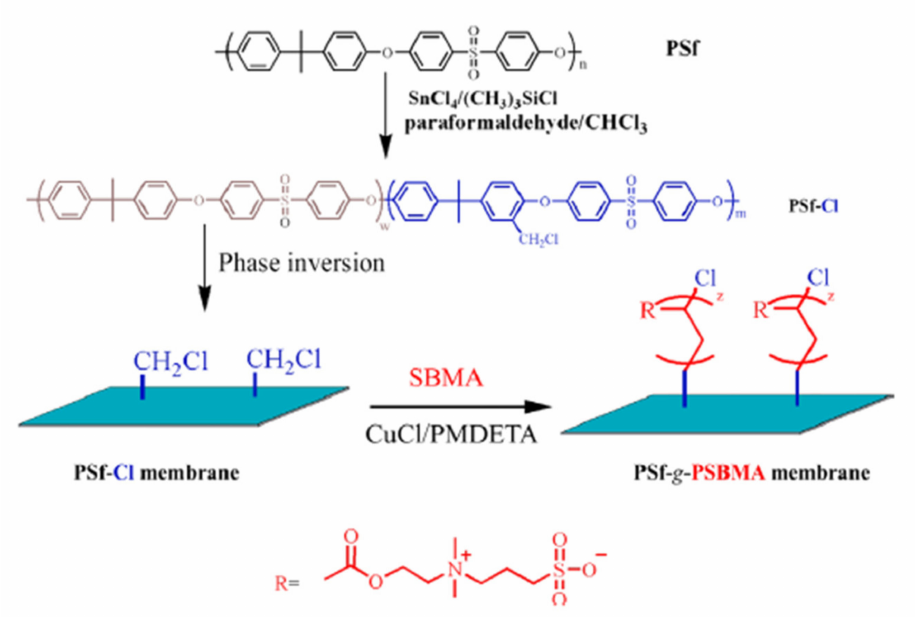
Figure 6. Scheme illustration of the preparation of PSF-g-PSBMA membrane (reproduced with permission after